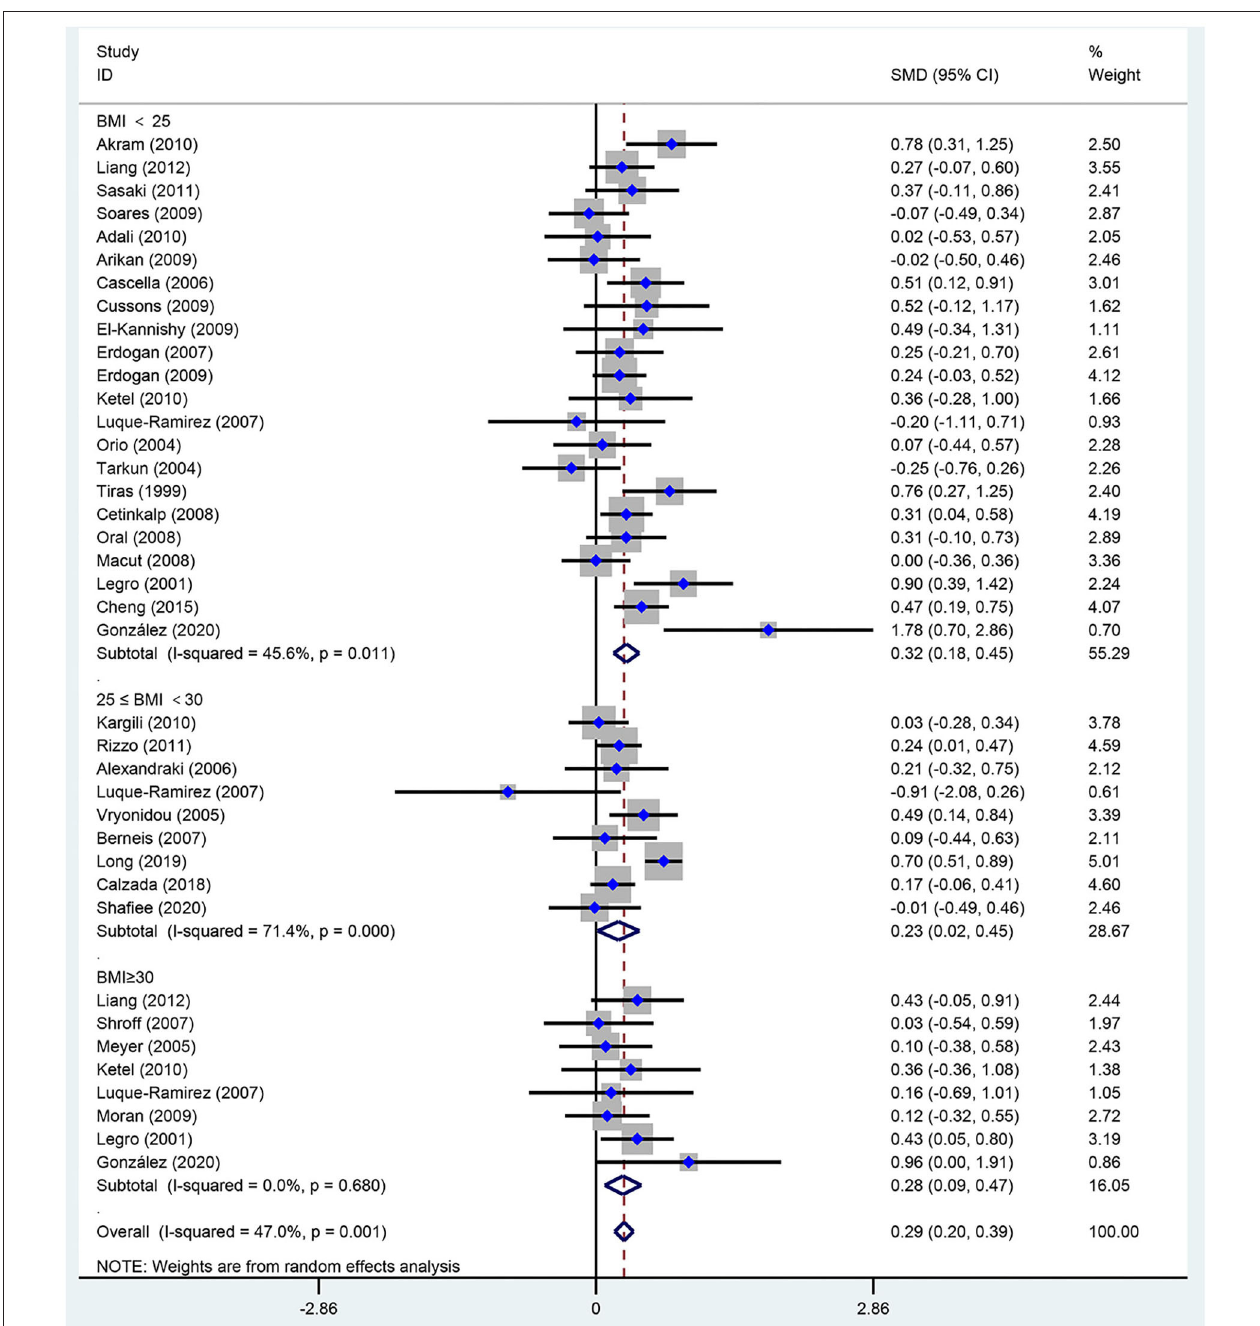
FIGURE 5 | Forest plot for comparison of low-density lipoprotein-cholesterol in polycystic ovary syndrome vs. control subjects. Studies are classified by different body mass index (BMI) categories (BMI < 25 kg/m 2 , BMI ≥ 30 kg/m 2 , and BMI 25–30 kg/m 2 ).